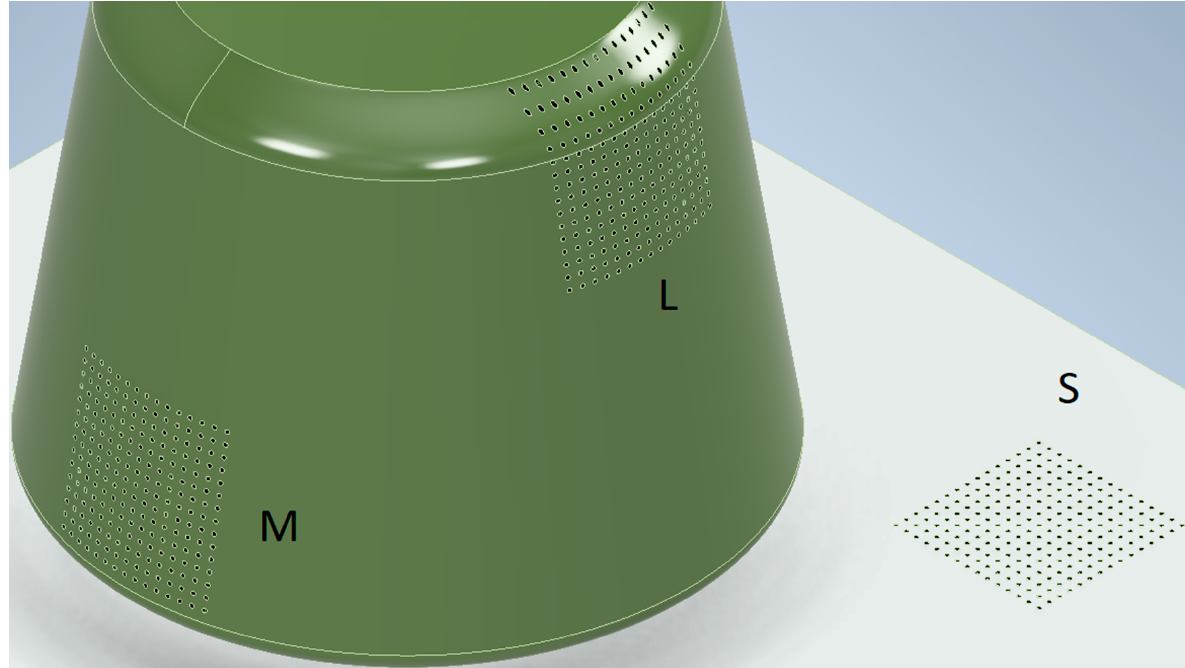
Figure 12. Marker grid projected onto a surface of various shapes: small deformation of the measurement point grid (S); medium deformation of the measurement point grid (M); large deformation of the measurement point grid (L).